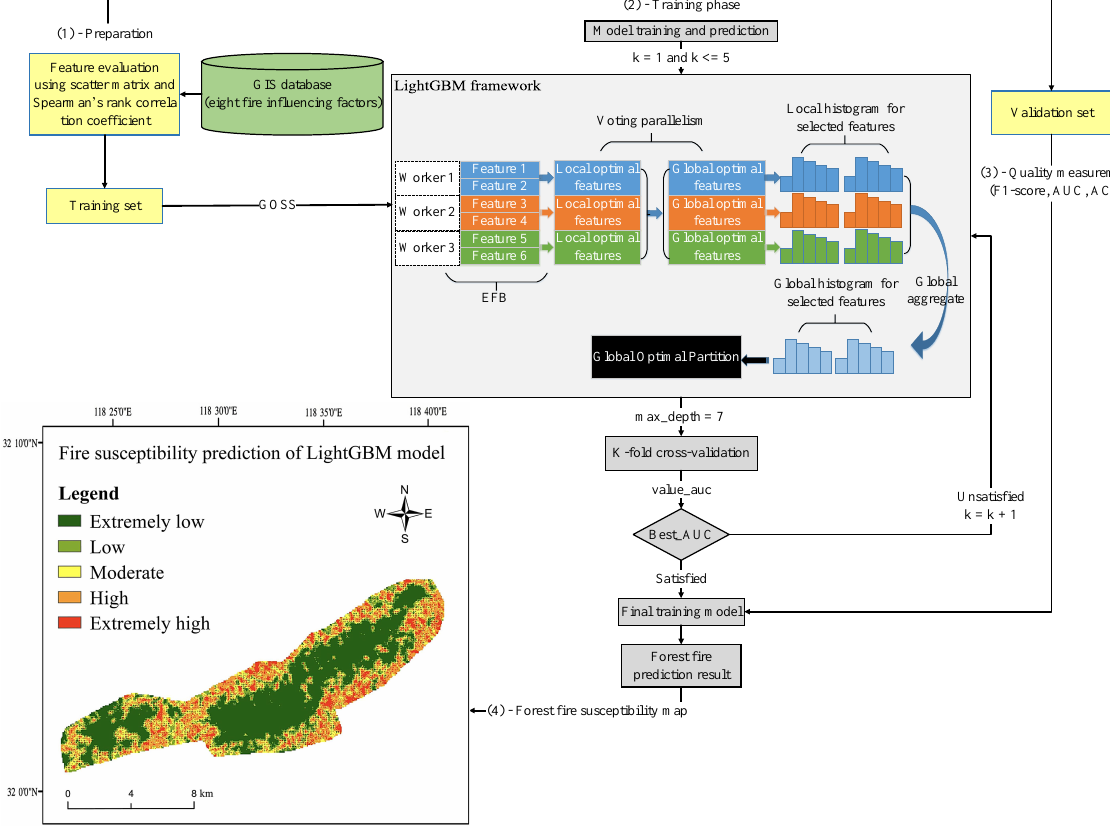
Figure 4. LightGBM model